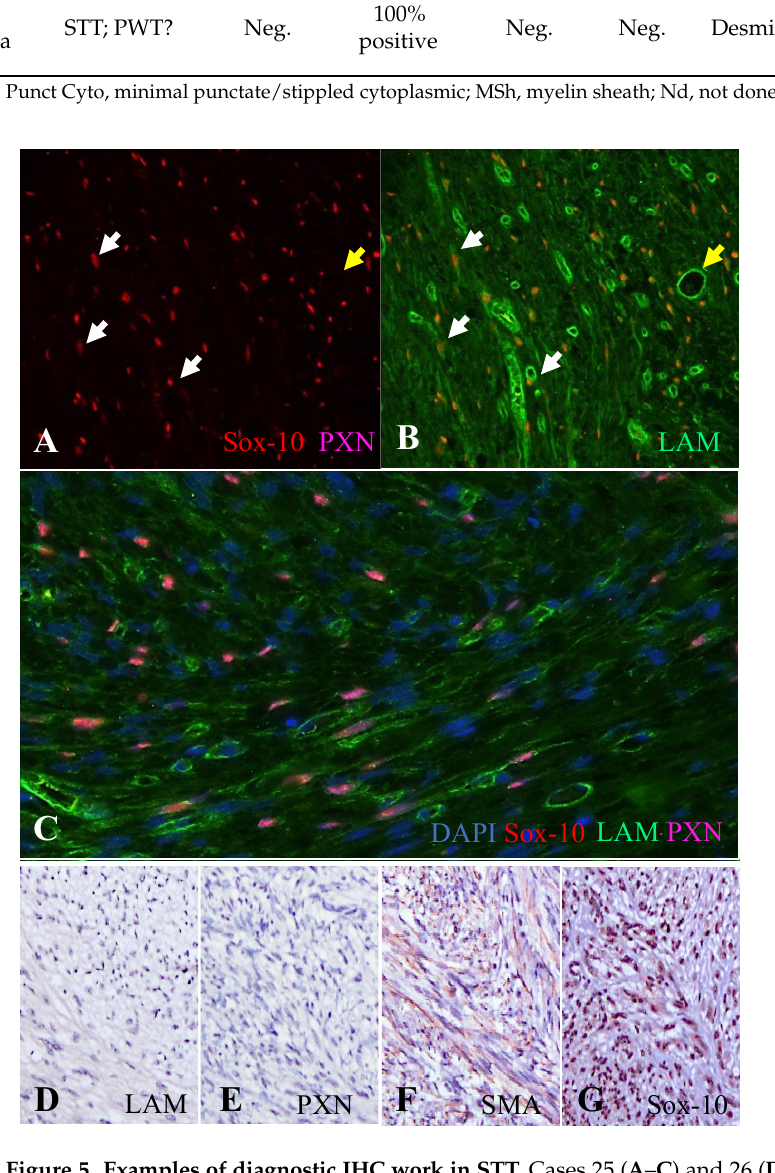
Figure 5. Examples of diagnostic IHC work in STT. Cases 25 ( A – C ) and 26 ( D – G ). A multiplex immunoflurorescence IHC for laminin (LAM), Sox-10 and periaxin-1 (PXN) on a benign NST ( A – C ) demonstrates frequent Sox-10+ nuclei (in red) of Schwann cells with no detected PXN+ axons ( A ). Note that LAM+ myelin sheaths (in green) with Schwann cells in red (white arrows) can be distinguished